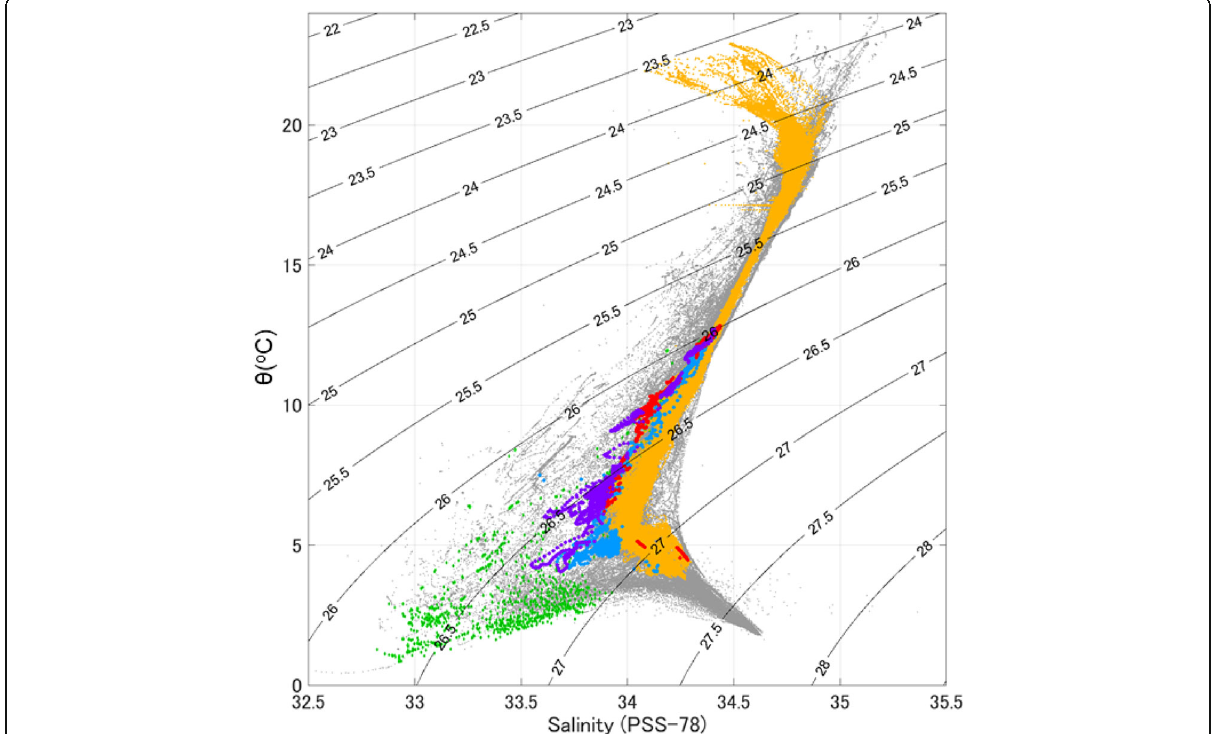
Fig. 7 θ -S relations of the Seaglider data with over 3 σ of negative salinity anomaly (blue circles), positive DO anomaly (red circles), and both (purple circles) during Apr. 28 – May 7, 2014. Orange dots represent all Seaglider data for Feb. 27 – Jun. 21. Background gray dots show Argo data observed in 25 – 45° N, 140 – 160° E for Jan. 1 – Apr. 30, 2014. Green dots are the same Argo data but observed in the upper subpolar region above 300 dbar at 41 – 45° N, 142 – 160°